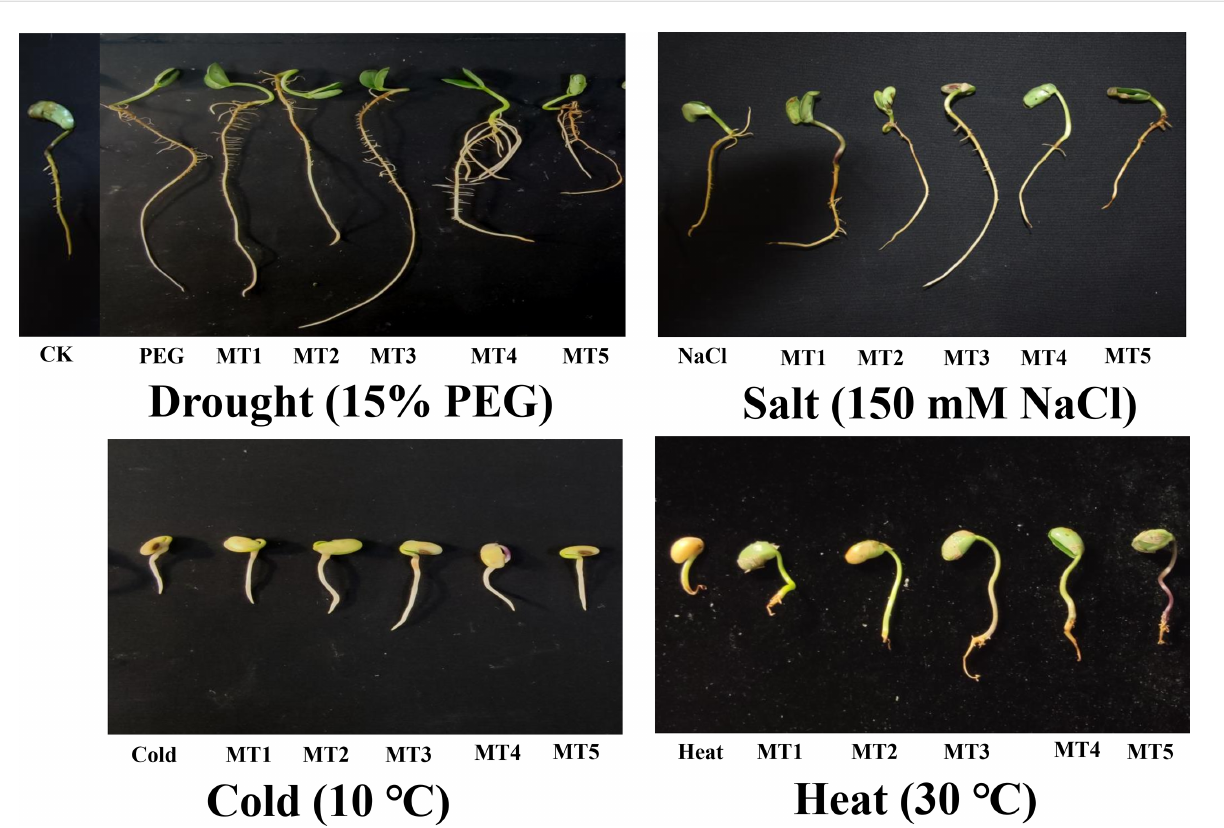
FIGURE 1 Effect of different concentrations of melatonin on the morphological representation of soybean germination PEG (15%), NaCl (150mM), Cold (10 °C), and Heat (30°C).